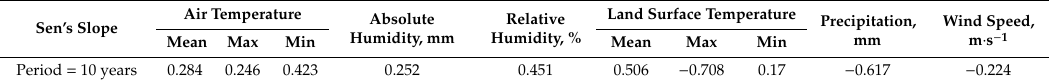
Table 2. Sen’s slope of all meteorological parameters.